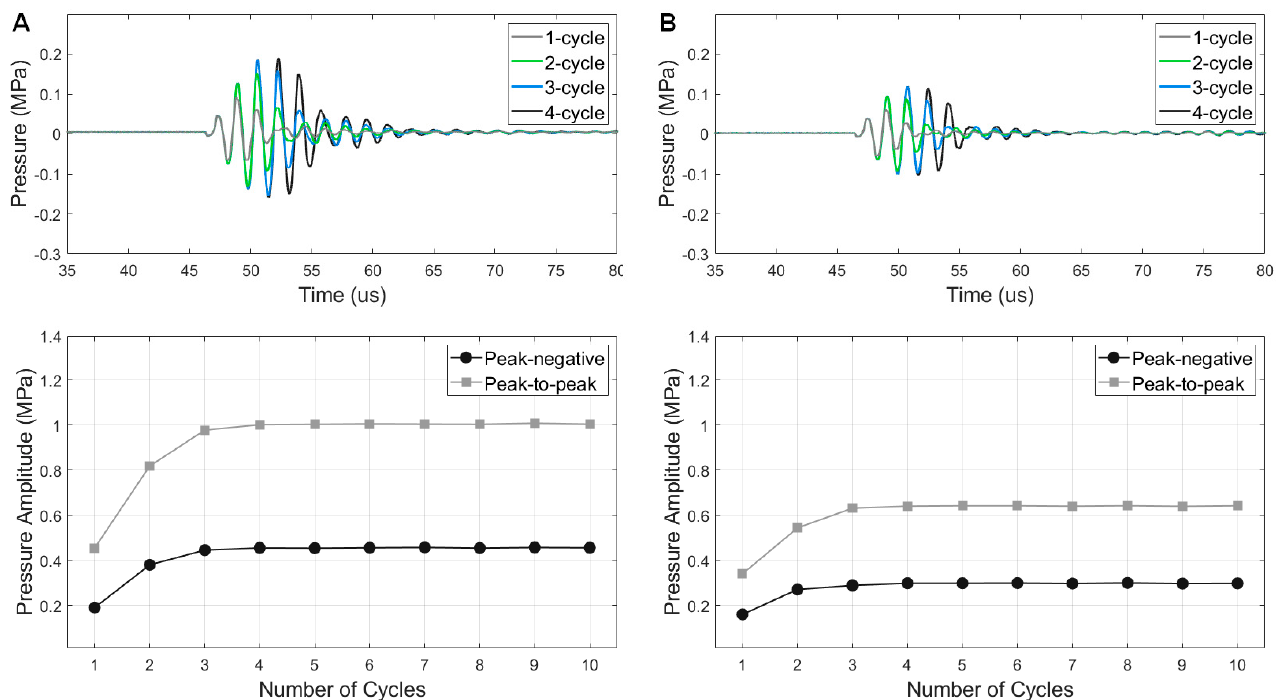
Figure 7. Output-pressure amplitude vs. the number of cycles. Time-domain waveforms of 1 − 4 burst cycles ( upper ) and the corresponding peak amplitudes ( lower ) of type A transducer ( A ) and type B transducer ( B ).